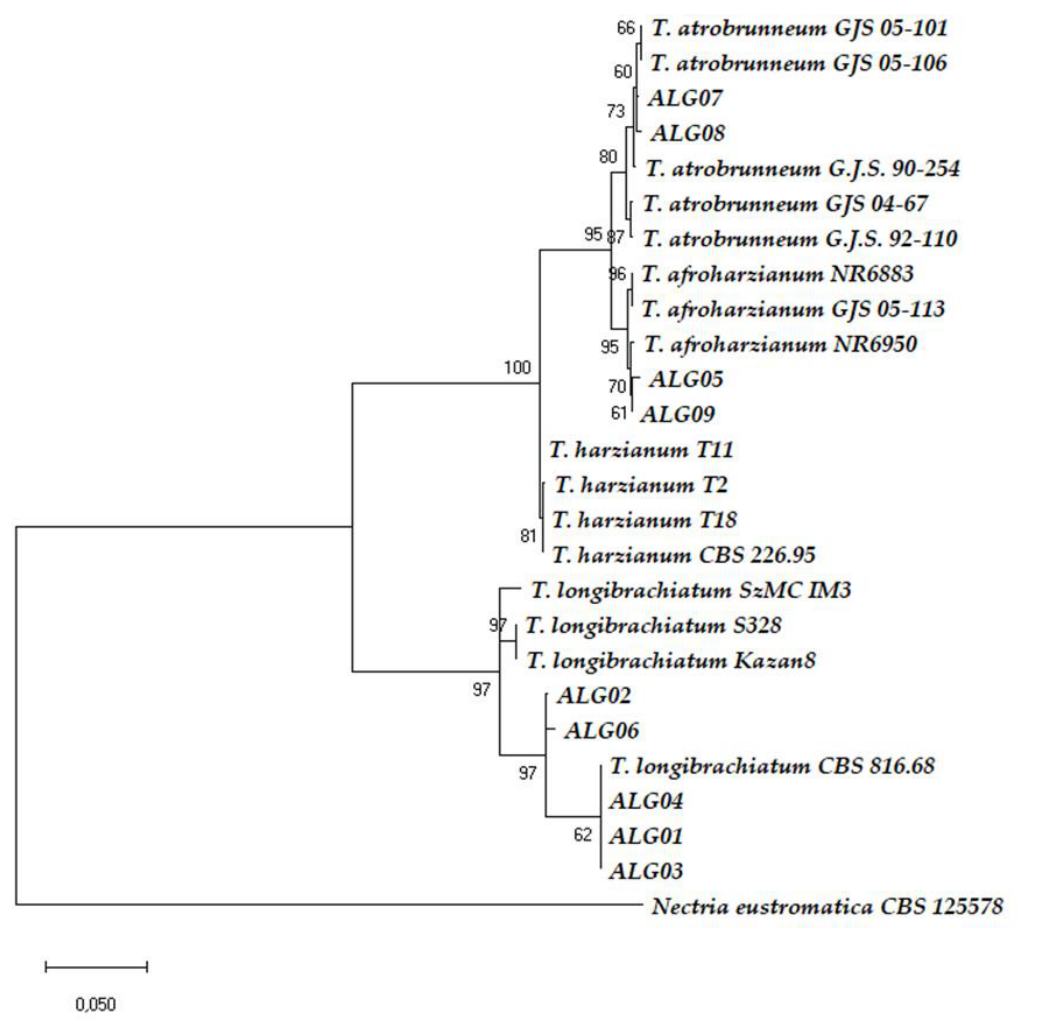
Figure 3. Phylogenetic tree of concatenated ITS + tef1 sequences from 26 Trichoderma strains. The ITS + tef1 sequences from Nectria eustrimatica was used as the out-group. The scale bar represents the number of expected substitutions per site.